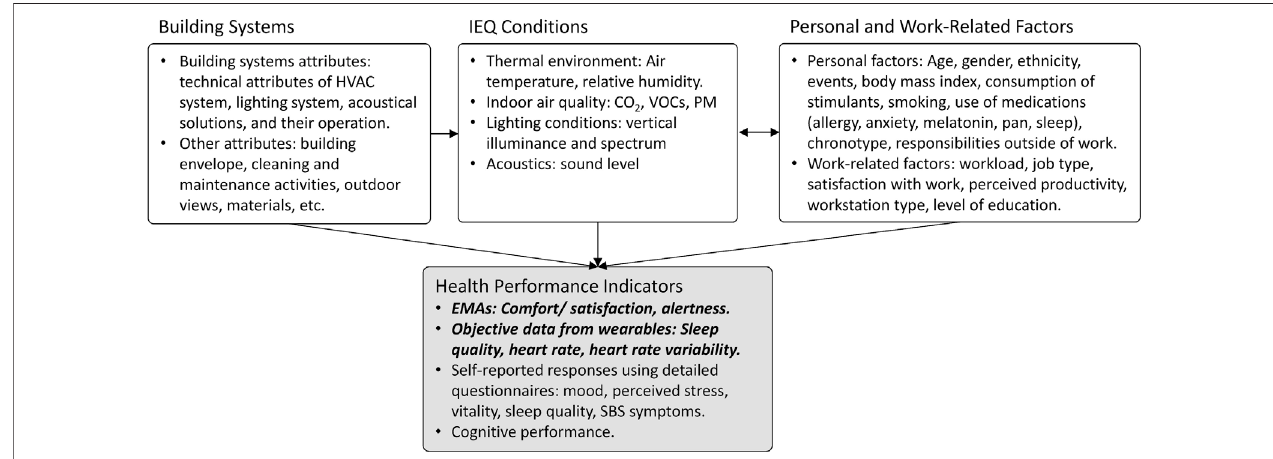
FIGURE 1 | A diagram showing four main data types that are needed for a holistic evaluation of IEQ. Bold italic font denotes HPIs that can be collected from wearables.